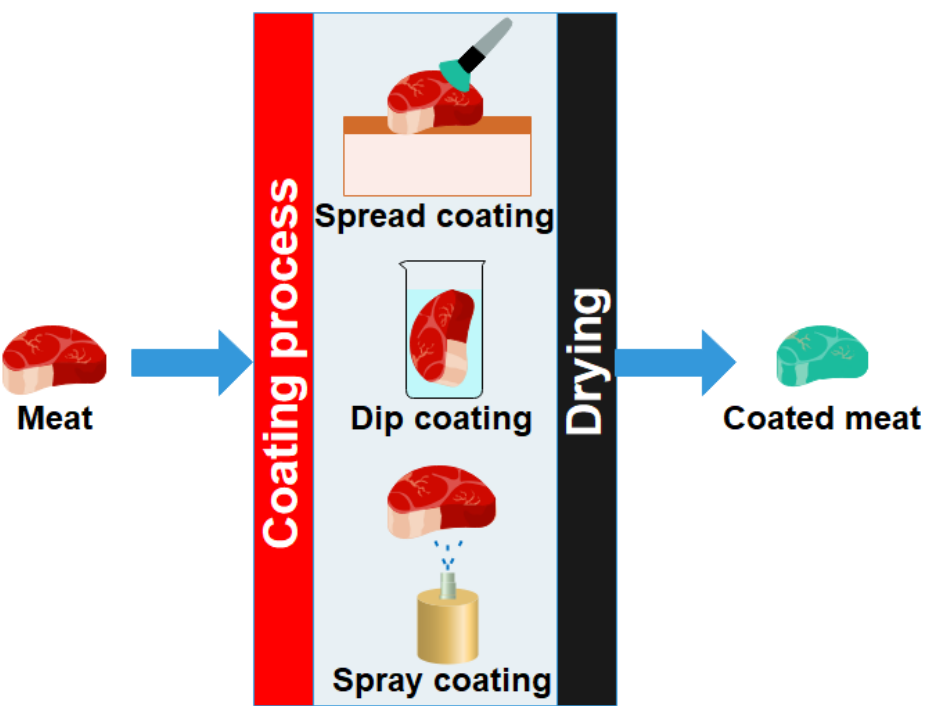
Figure 12. Schematic representation of spread coating, dip coating, and spray coating.